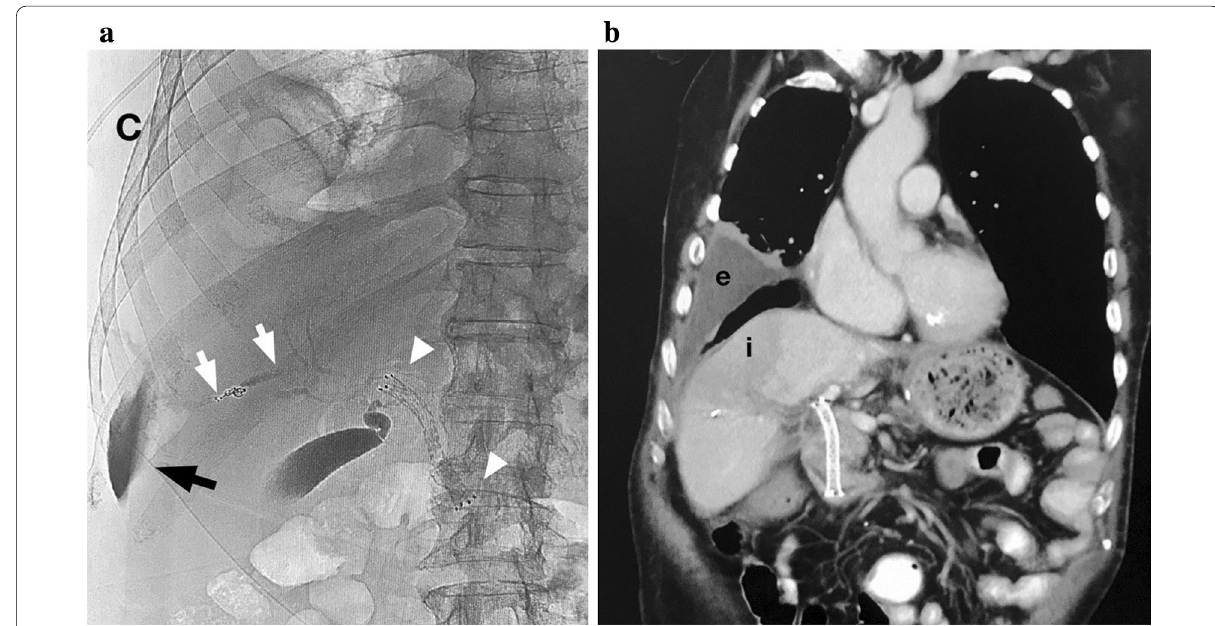
Fig. 3 a Final image post-stent placement (white arrowheads) and tract sealing (white arrows). Black arrow points at the opacified right pleural sulcus. C: pleural drainage catheter. b Coronal CT reconstruction of the chest and upper abdomen two months post-intervention shows stent in place and no biliary dilatation. There is residual right pleural effusion (e) and a right hepatic parenchymal infarct (i) from right portal vein